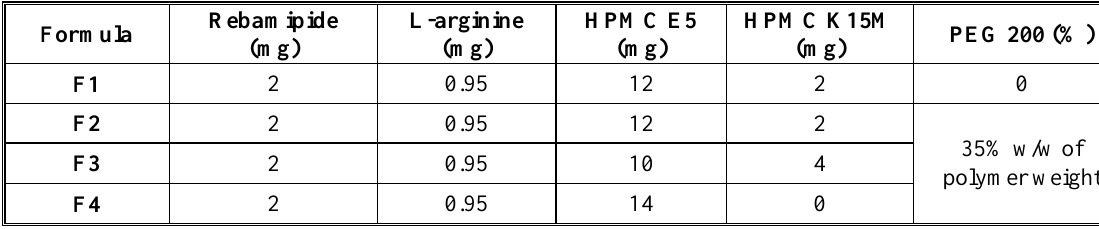
Evaluation of rebamipide ocular